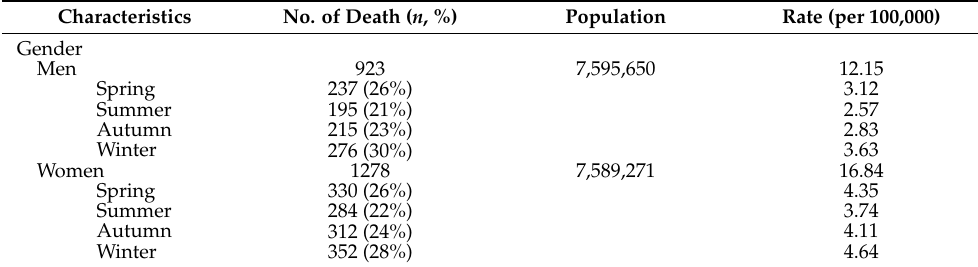
Table 1. The distribution of diabetes death by gender, age and season in 31 death surveillance points in Shandong Province, China,